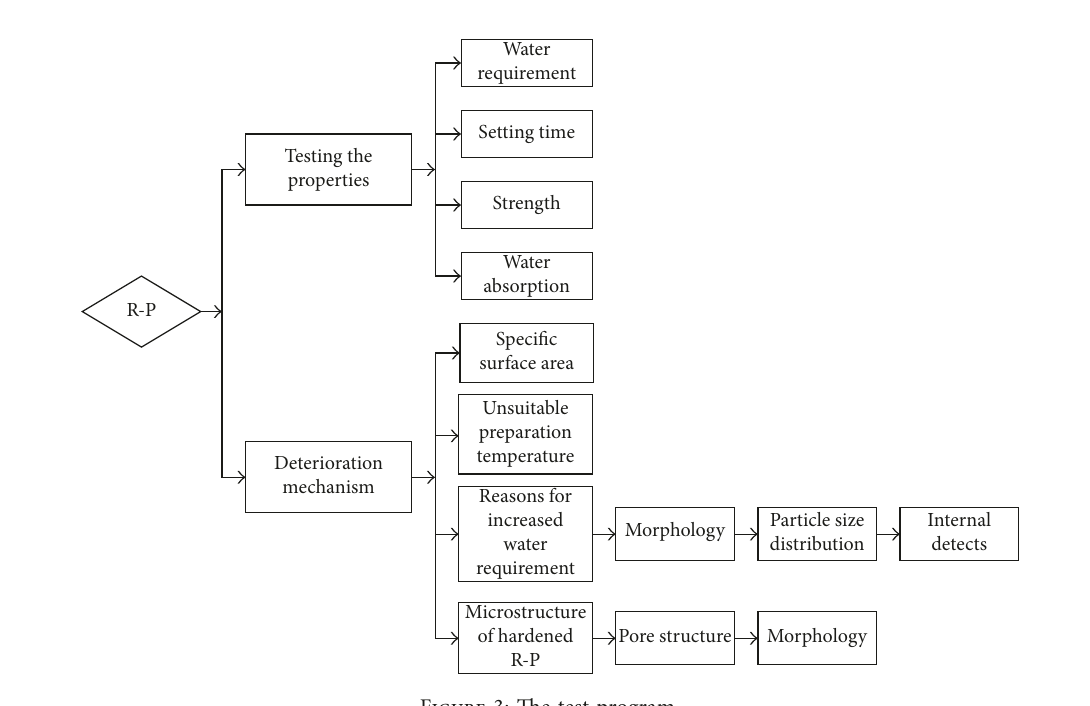
Figure 3: The test program. Table 3: Properties of POP and R-P under the same preparation process.